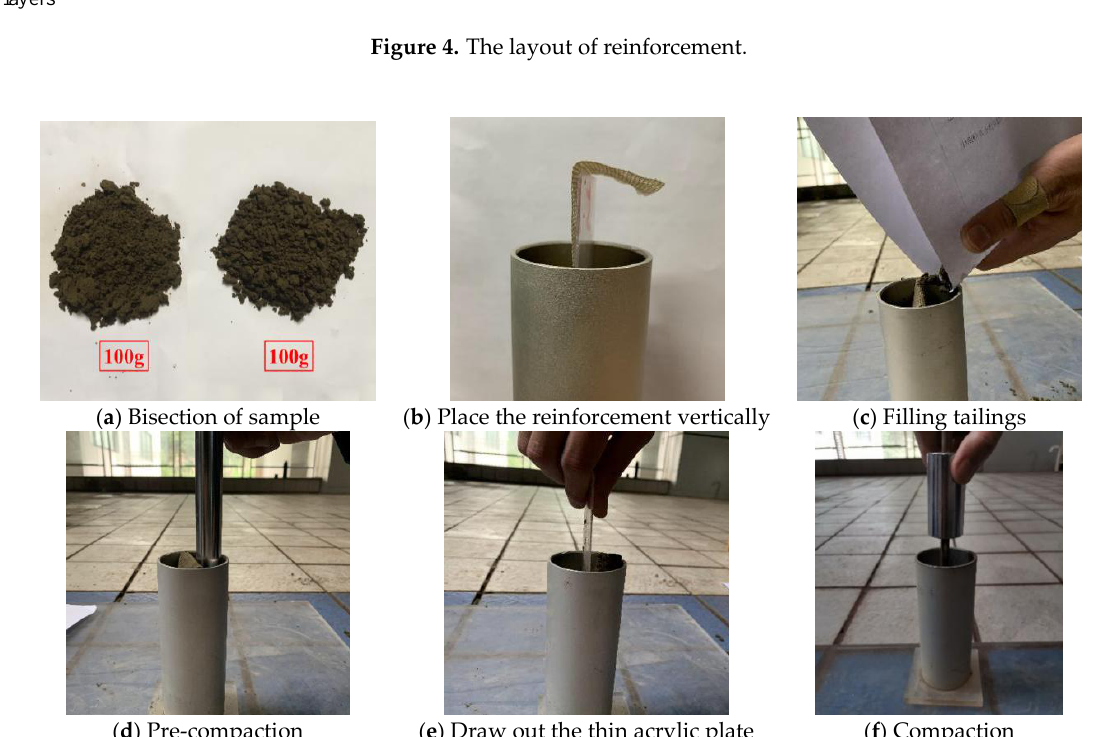
Figure 5. Preparation process of the reinforced tailings sample.